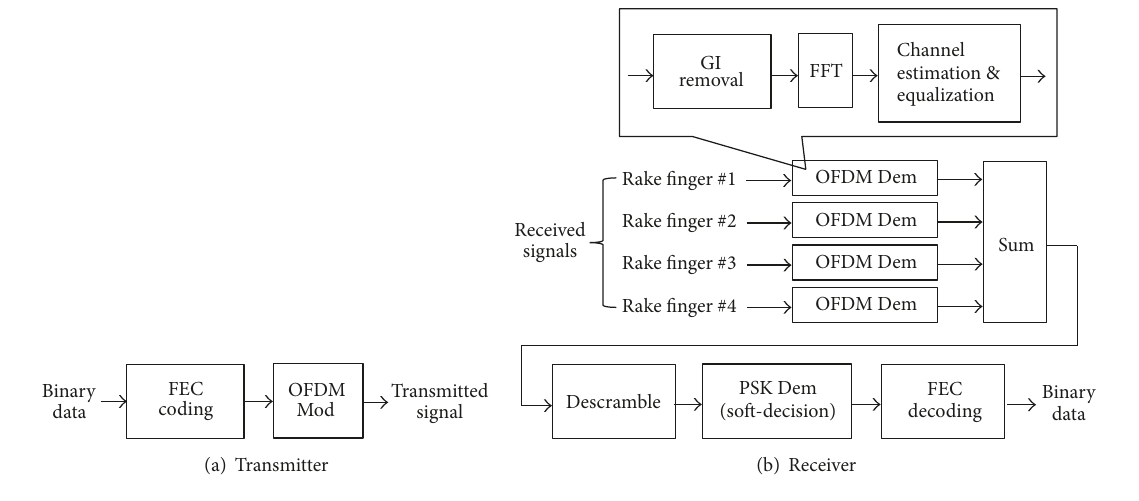
Figure 12: MRC rake reception (MRCRake).